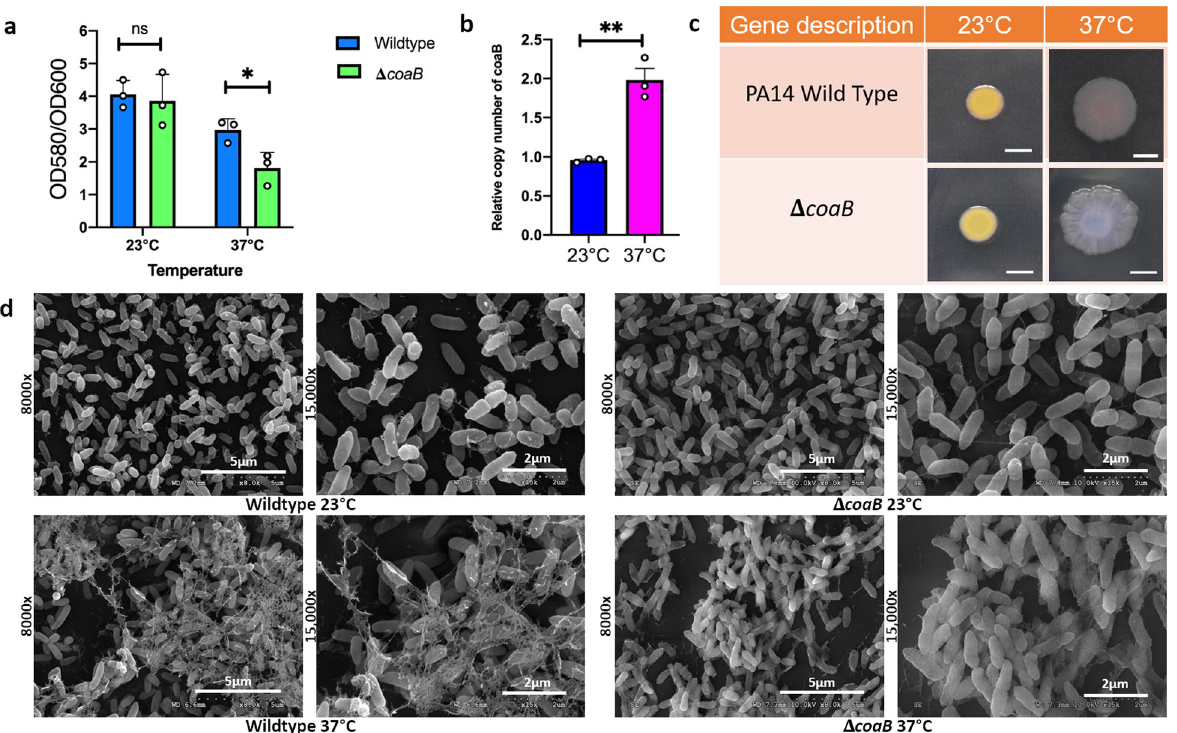
Fig. 4 The Pf1 fi lamentous phage coat B protein speci fi cally contributes to P. aeruginosa PA14 bio fi lm EPS at human body temperature but not at room temperature. a Crystal violet staining was performed to assess air-liquid bio fi lm formation in a 96-well microtiter plate at 48 h. Strains were grown in LB broth at appropriate temperatures. Bars represent the mean of three biological replicates performed on different days. The mean of each biological replicate was based on three technical replicates. Error bars represent the standard error of mean of the biological replicates. Unpaired t -test (two-tailed) was used to measure statistical signi fi cance. * p = 0.038, ns, p = 0.6071. b qPCR was performed on DNA extracted from bio fi lm grown for 48 h at 23 and 37 °C using primers speci fi c for coaB and the housekeeping gene rplU using an established mechanical dissociation method 42 . Bars represent the mean of three biological replicates performed on different days. The mean of each biological replicate was based on three technical replicates. Error bars represent the standard error of mean of the biological replicates. Unpaired t -test (two-tailed) was used to measure statistical signi fi cance. ** p = 0.0028. c Congo red binding assay. Extracellular matrix production by the wild type and mutant strain was evaluated on tryptone agar plates containing Congo Red and Coomassie brilliant blue G after incubation at 23 and 37 °C for 72 h. Representative images of the colony morphologies of WT PA14 and the Δ coaB mutant are shown. Scale bar: 5 mm. d Comparison of the scanning electron microscopy images of Pseudomonas aeruginosa wild-type bio fi lms and Δ coaB mutant bio fi lms grown for 48 h at 23 and 37 °C. Images show ×8000 and ×15,000 magni fi cation and are representative of three independent